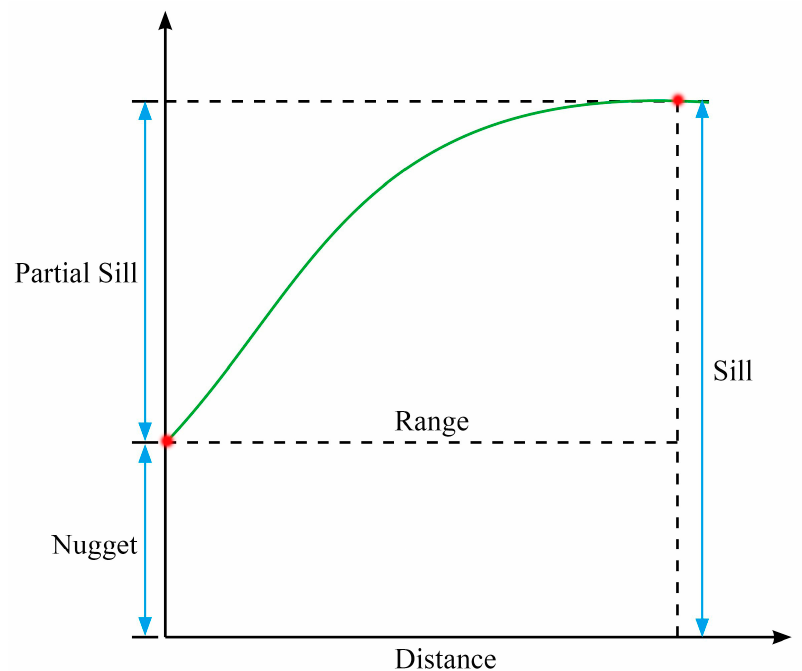
Figure 7. Semi-variance function theoretical diagram. Nugget represents the variation caused by measurement or scale. Sill represents the sum of random variation and fixed variation. Partial Sill is the difference between Sill and Nugget. When the value of the semi-variance function is taken from the initial Nugget to the Sill, the interval distance of the sampling points is called the Range. The Sill effect (Nugget/Sill) is an important indicator of the degree of spatial autocorrelation; the smaller its value, the stronger the degree of spatial autocorrelation.